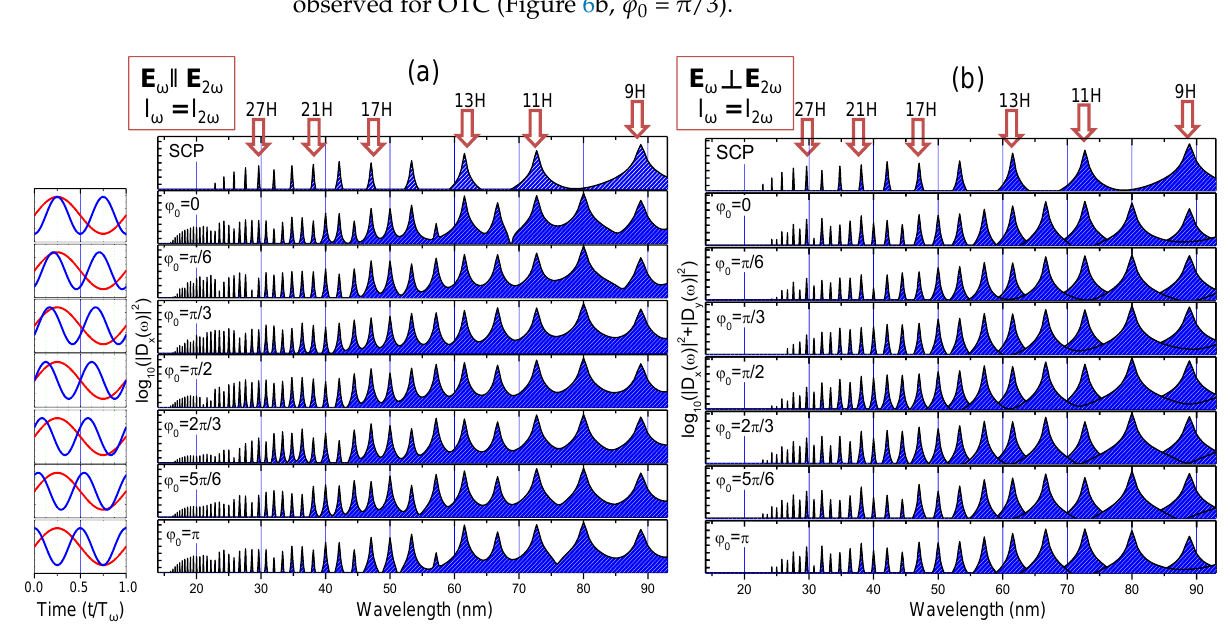
Figure 6. Calculated HHG spectra for PTC ( a ) and OTC ( b ). The φ 0 designates a relative phase shift for ω - 2ω fields, schematically presented in first column by red (800 nm) and blue solid (400 nm) lines. The intensities of ω and 2 ω are equal, while the orientation of polarization vectors is parallel in panel ( a ) and orthogonal for panel ( b ). Upper panels (SCP) present the calculated HHG with only 800 nm field.